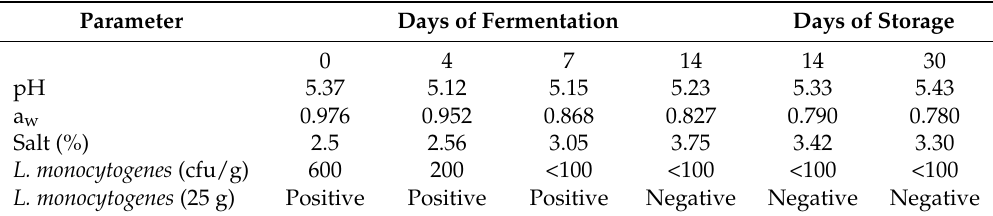
Table 2. Results of the physicochemical and microbiological analyses of naturally contaminated dry sausages during fermentation and